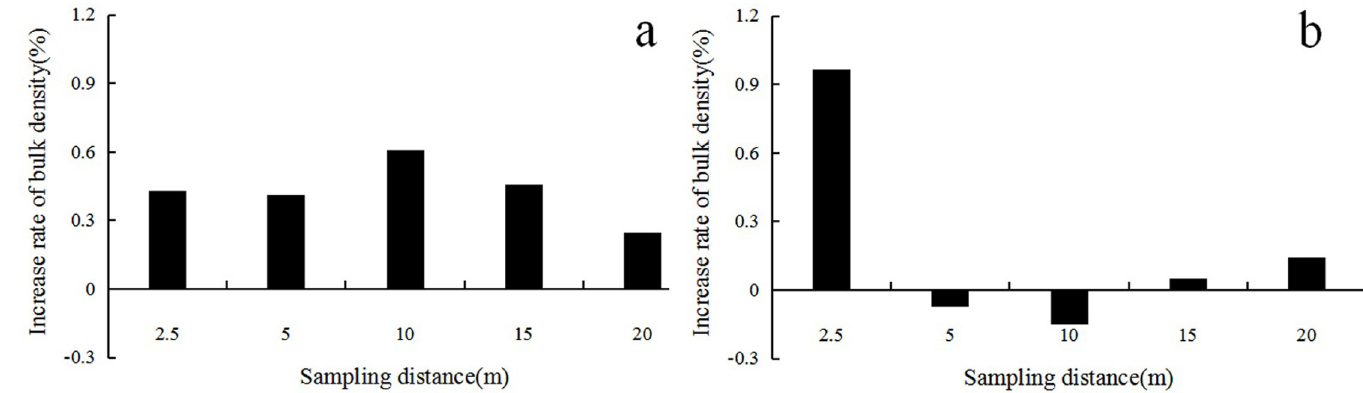
Fig 2. Soil bulk density at different sampling